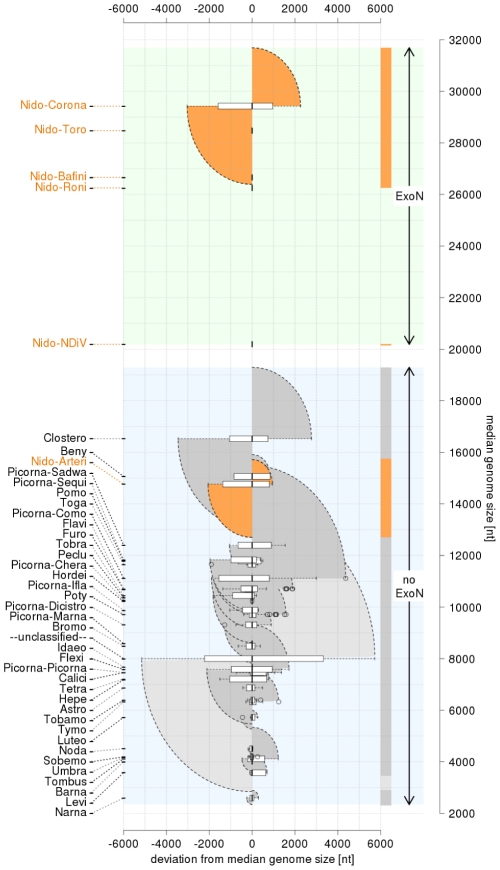
Distribution of positive-sense single-stranded RNA virus genome sizes.The Coronaviridae is split into the corona- and toro-/bafinivirus groups. Prefix Nido- and Picorna- are for Nidovirales and Picornavirales, respectively. Group specific box-whisker plots are aligned along the X-axis by their medians (bold line) normalized to zero. The box spans from the first to third quartile; the whiskers (dashed lines) are <1.5 times the inter-quartile range; outliers are circles. Families/groups are ranked by median genome size along Y-axis. Genome size ranges are colored by semi-circles: nidoviruses (dark orange), other classified (dark grey) and unclassified viruses (light grey). Three non-overlapping zones regarding the presence of the exoribonuclease (ExoN) are highlighted in the genome size distribution (from top to bottom): ExoN-encoding large nidoviruses and NDiV (light green); in-between not-sampled size zone (white); ExoN-lacking ssRNA+ viruses (light blue).